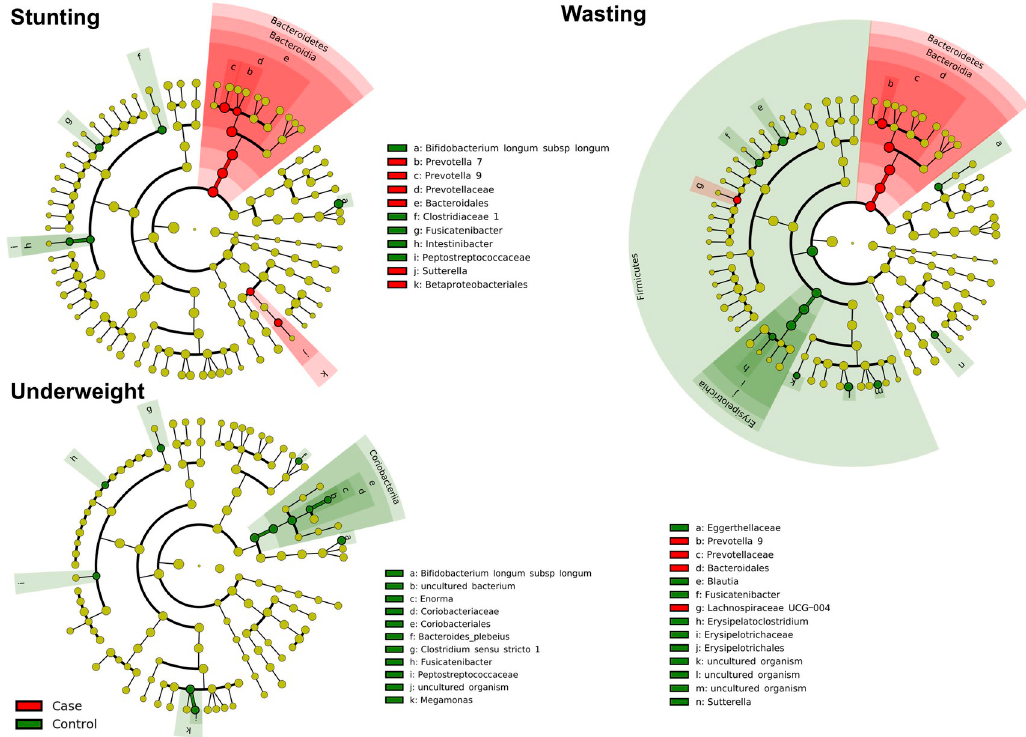
Fig 3. Fecal microbiota characterization cladograms of stunting, wasting and underweight in 18–24 month old Indian children. The fecal microbiota characterization cladograms were based on LEfSe (linear discriminant analysis Effect Size) in the study